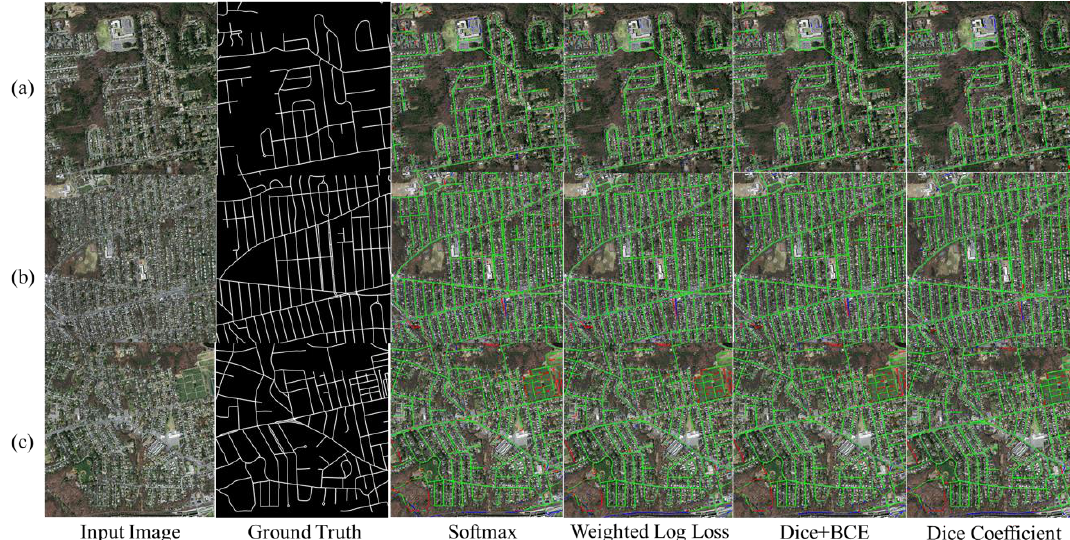
Figure 7. Visual comparison of four loss functions used with Nested SE-Deeplab on the testing set. True positive (TP) is marked as green, false positive (FP) as blue, and false negative (FN) as red. The three rows including ( a ), ( b ) and ( c ) in the figure represent visual effects of three examples in testing set, which have been tested by models with different loss functions. For each row in the figure, it contains an input image, a picture of ground truth and results of models with different loss functions including softmax cross entropy, weighted log loss, dice+bce and dice coefficient.